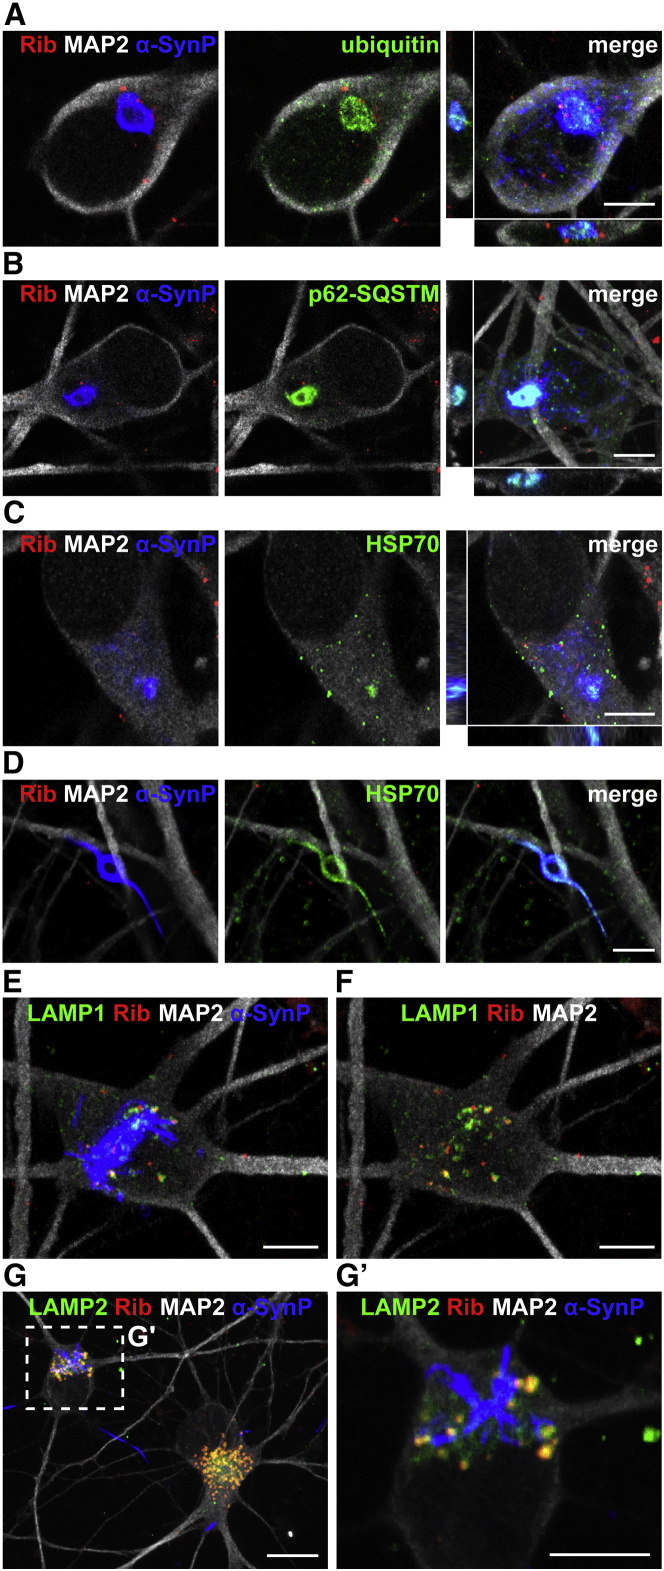
Characterization of α-SynP Somatodendritic Inclusions(A–D) (A) Anti-ubiquitin, (B) anti-p62-sequestosome1, and (C and D) anti-HSP-70 immunostaining (green) and colocalization with endogenous α-SynP aggregates (blue) in neurons (MAP2, white) treated with ribbons (abbreviated here Rib, red) at 21 dpe. HSP-70 labeled the dense core of (C) somatic or (D) neuritic α-SynP inclusions. For each line the first two images represent single plane, whereas merge panels are composed of z stack projection.(E–G) (E and F) LAMP1 and (G and G′) LAMP2 immunostaining (green) largely colocalized with exogenous assemblies (ribbons, red) but did not show appreciable association with α-SynP structures (blue).Scale bars: 5 μm in (A–F and G′); 10 μm in (G).